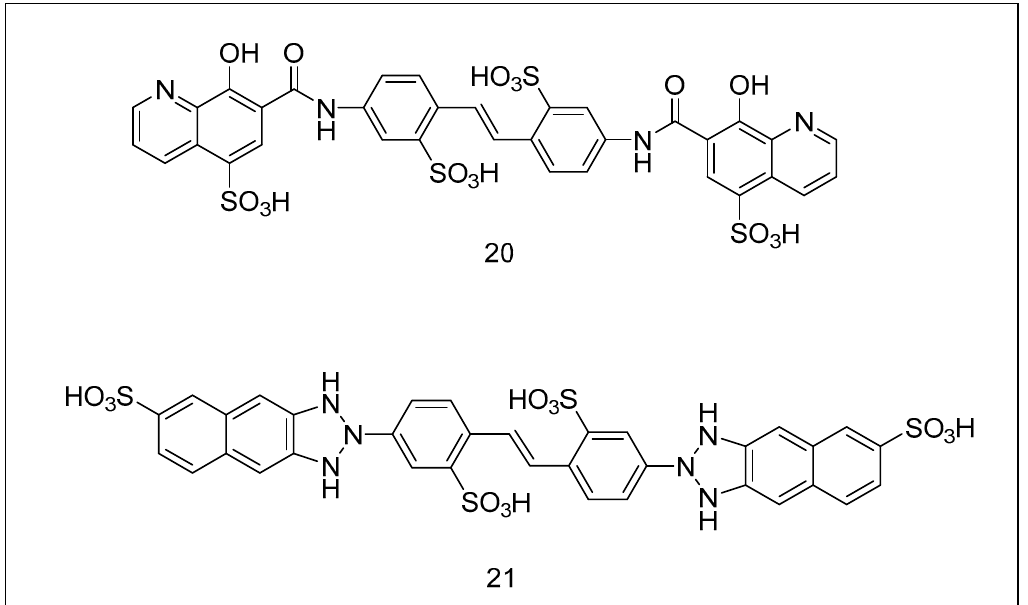
Figure 8. Chemical structures of ( 20 ) ubistatin A and ( 21 ) ubistatin